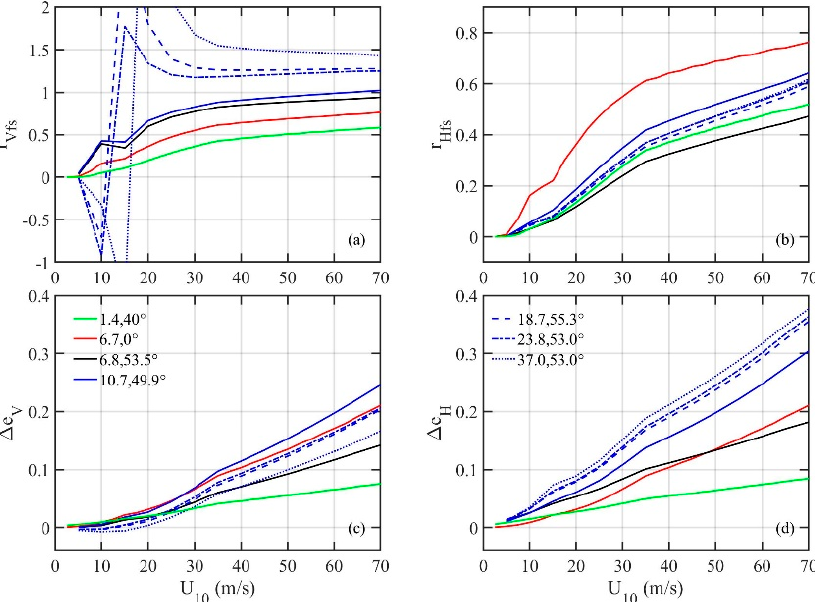
Figure 5. Foam-to-sum ratio r pfs : ( a ) vertical polarization, ( b ) horizontal polarization. Excess emissivity ∆ e p : ( c ) vertical polarization, ( d ) horizontal polarization.